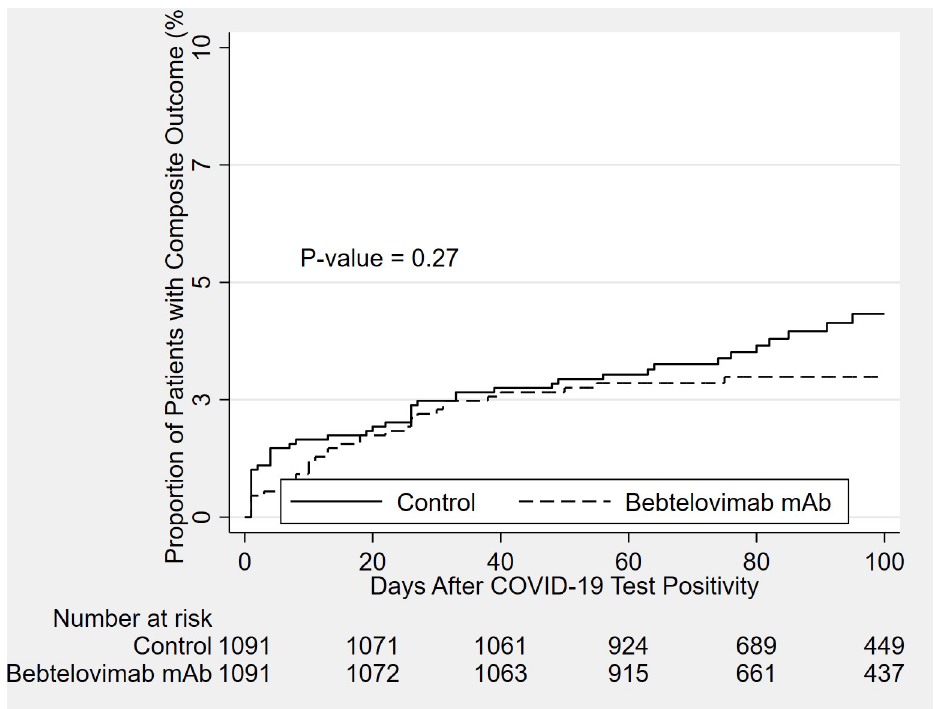
Fig 2. Kaplan Meier curves for the composite outcome in patients who received Bebtelovimab monoclonal antibody treated group vs. not-treated control group between April 5, 2022, and August 1, 2022.